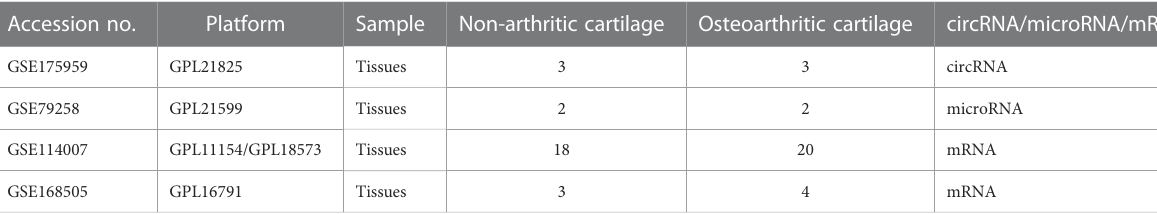
TABLE 1 Characterization of the four datasets from the GEO database. Accession